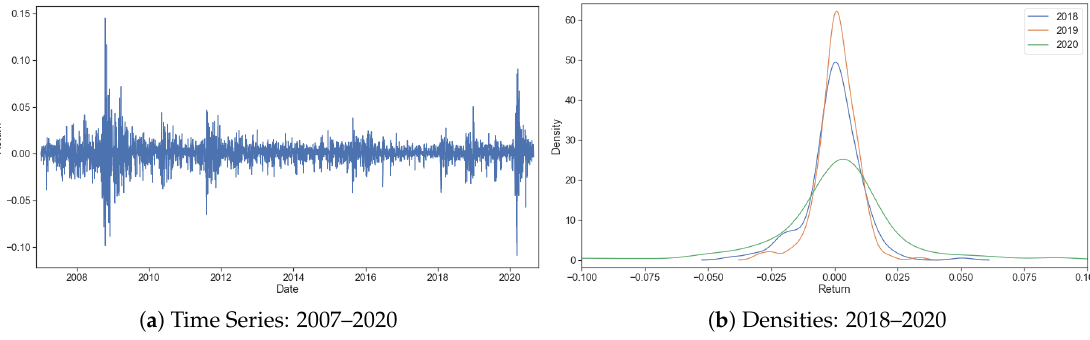
Figure 2. SPY ETF